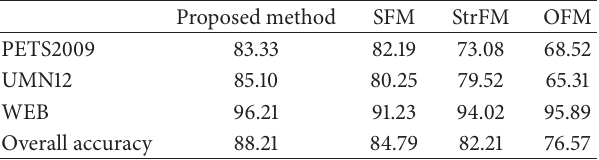
Table 1: Accuracy comparison of the proposed method with SFM,